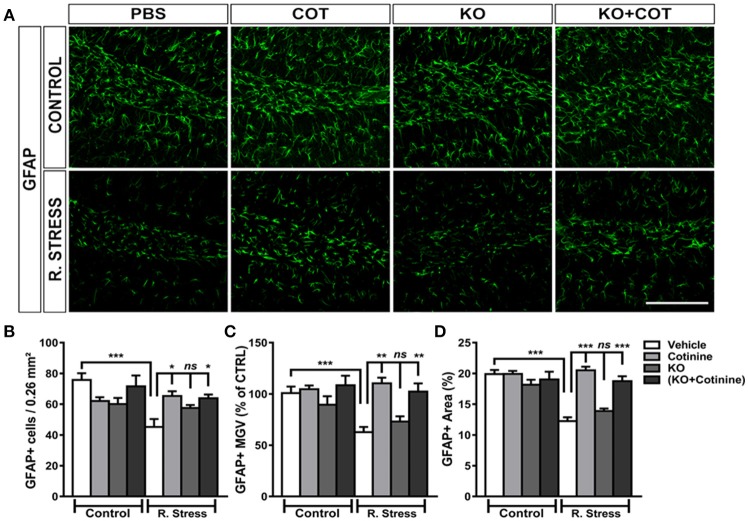
Analysis of the effect of cotinine plus krill oil on astrocytes in the dentate gyrus of the hippocampus. A figure representing the changes in cell GFAP+ cells numbers and morphology in the dentate gyrus region of the hippocampus in male mice subjected or not to restraint stress (R. Stress) (A). Graph depicting the changes in the number of GFAP+ IR cells (B); main gray values (MGV) (C); area of GFAP IR in the DG of vehicle-treated non-retrained mice or restrained (RS) mice, cotinine (Cot, 5 mg/kg) or Cot plus KO (143 mg/kg) (Cot + KO) (D). *P < 0.05, **P < 0.01, ***P < 0.001.